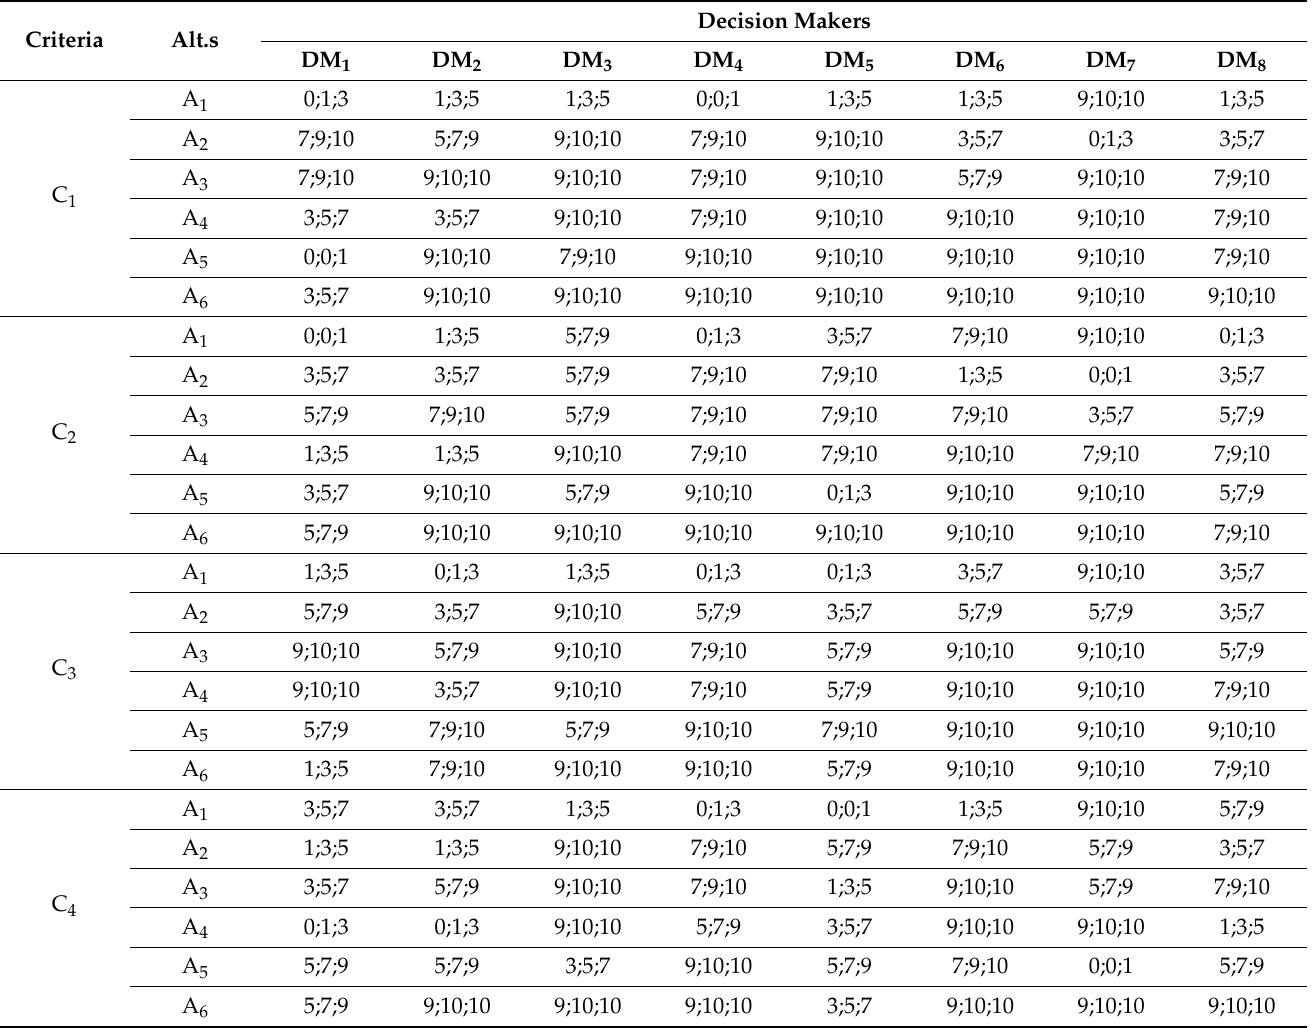
Table 7. Transfiguration of evaluations of leader alternatives into positive triangular fuzzy